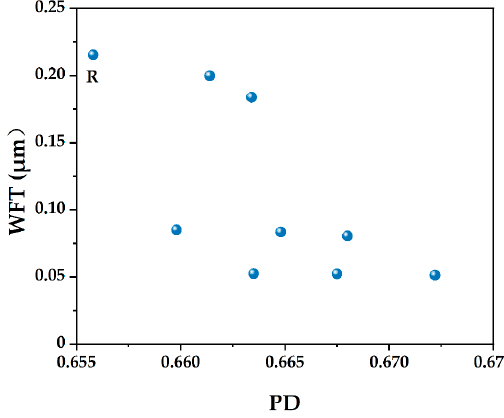
Figure 10. The relation between water film thickness and packing density.